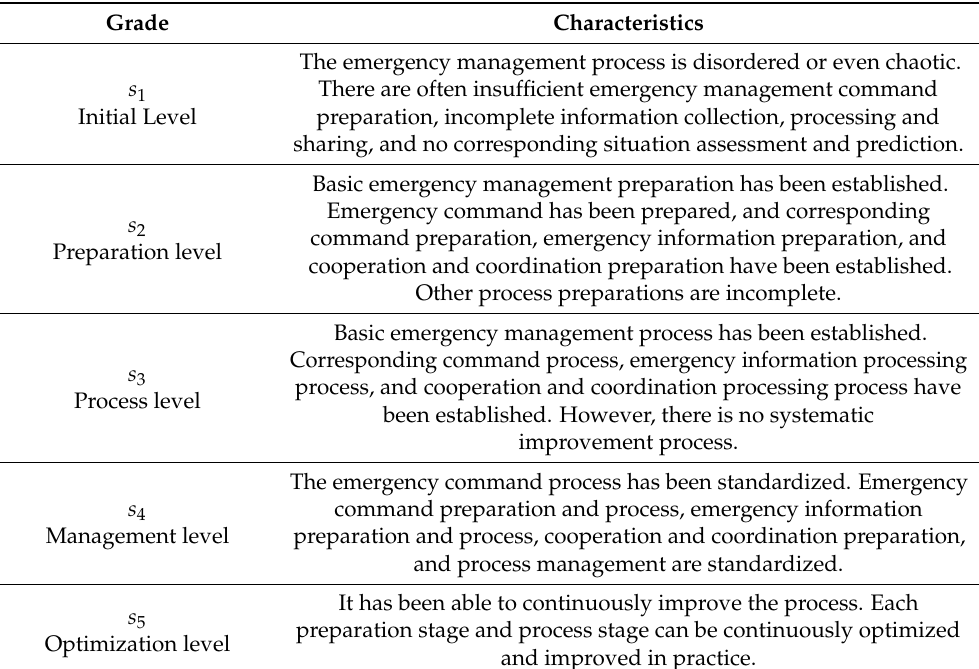
Table 2. Grade and characteristics of government emergency response capability level inspired by